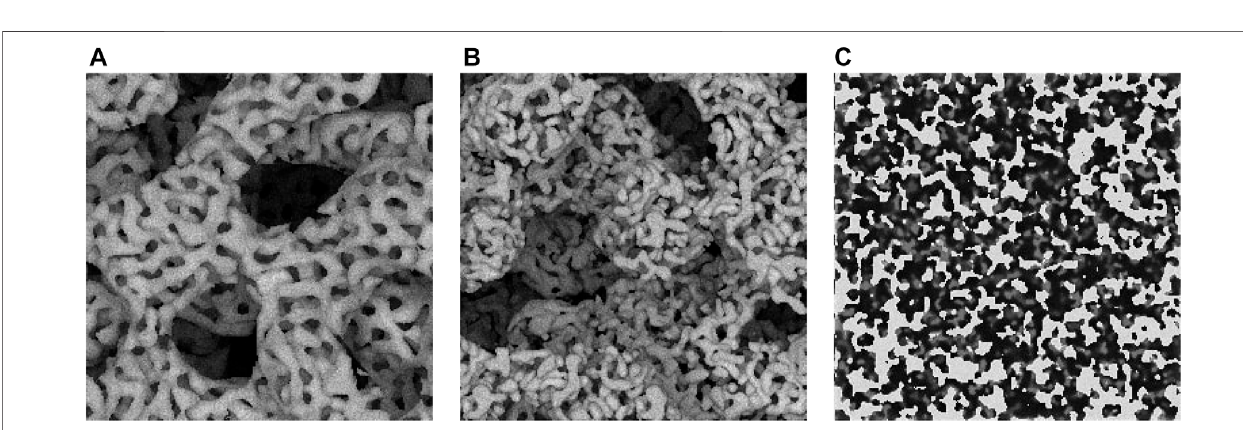
FIGURE 3 | Simulated BSE images using Monte Carlo simulation method and data generated using (A) LWM as initial virtual structure (B) SSM as initial virtual structure (C) RPGM as initial virtual